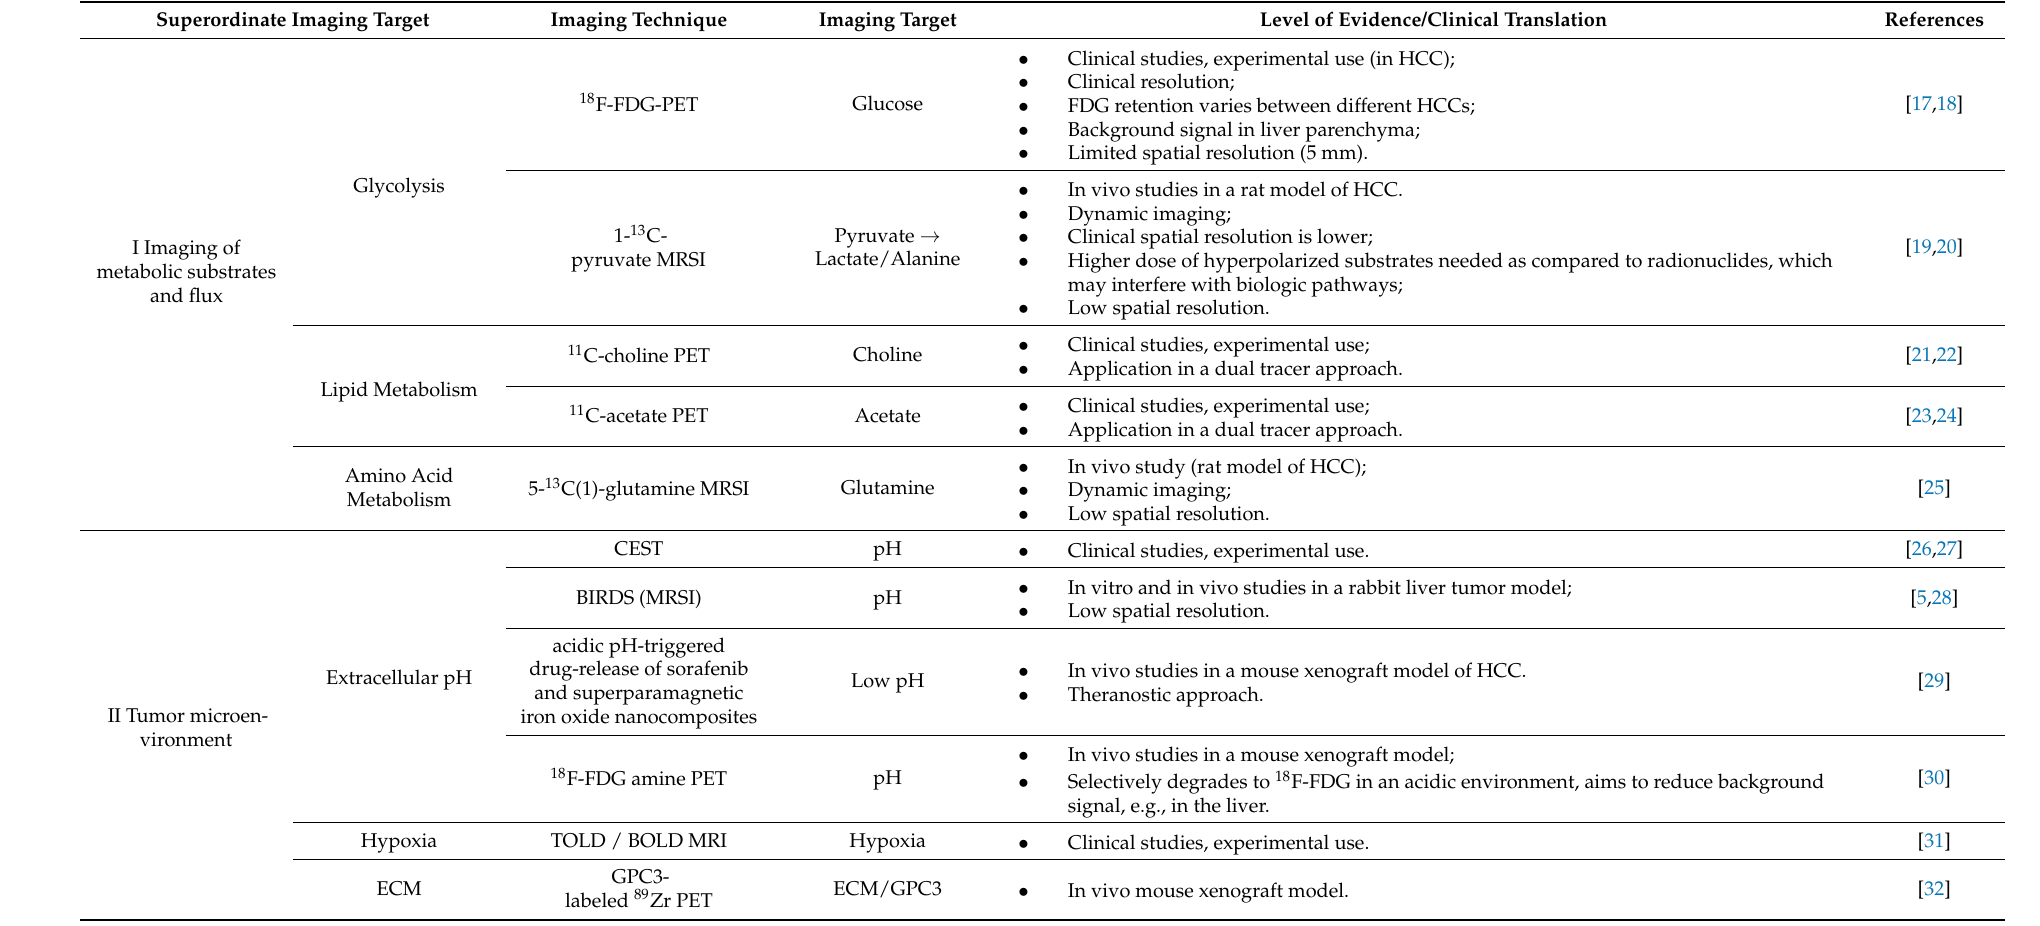
Table 1. Overview of imaging techniques targeting the crosstalk between the tumor cells and their tumor microenvironment mediated through tumor metabolism and their level of evidence and clinical translation in HCC. BOLD, blood-oxygen-level-dependent MRI; CEST, chemical exchange saturation transfer; ECM, extracellular matrix; FDG, fluorodeoxyglucose; Gd-HLA-DR, gadolinium-conjugated antibodies against HLA-DR; GPC3, glypican-3; HCC, hepatocellular carcinoma; MRI, magnetic resonance imaging; MRSI, magnetic resonance spectroscopic imaging; PET, positron emission computed tomography; SPIONs, superparamagnetic iron oxide nanoparticles; TOLD, tissue oxygenation level-dependent